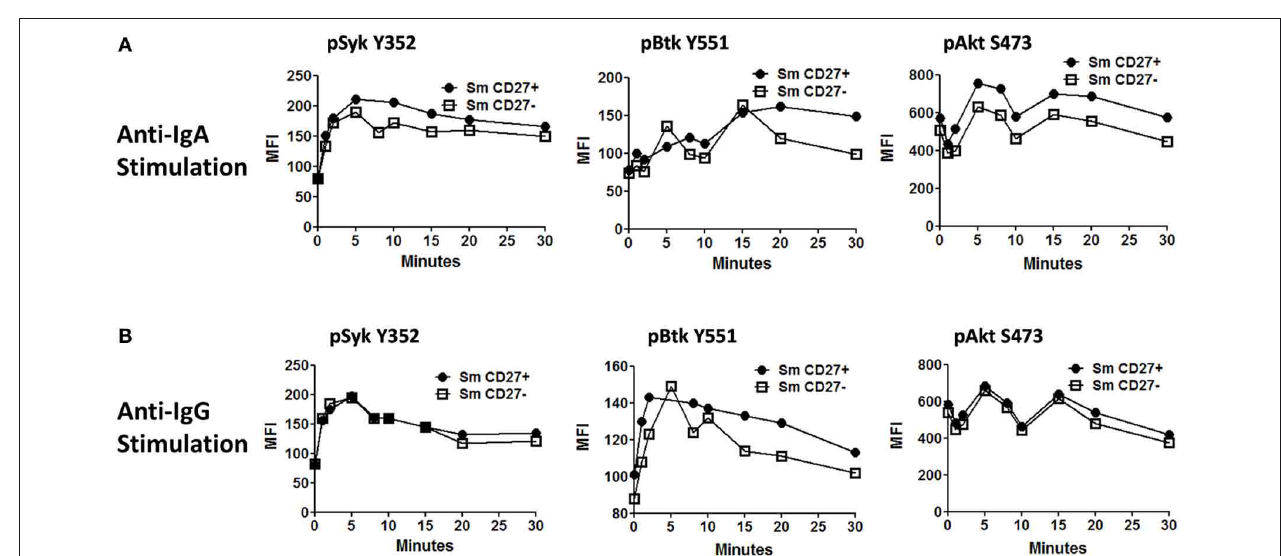
FIGURE 7 | Time course of phosphorylation of BCR-associated signaling proteins in Sm CD27 + and Sm CD27 − B cells following anti-IgA and anti-IgG stimulation. Anti-IgA and anti-IgG stimulated